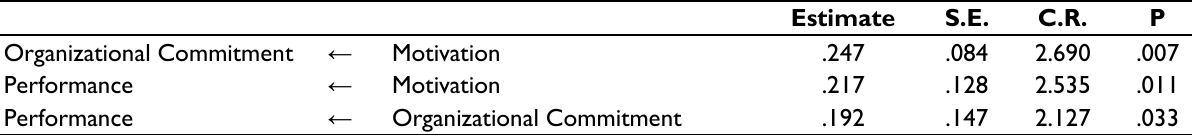
Table 4. Standardized Regression